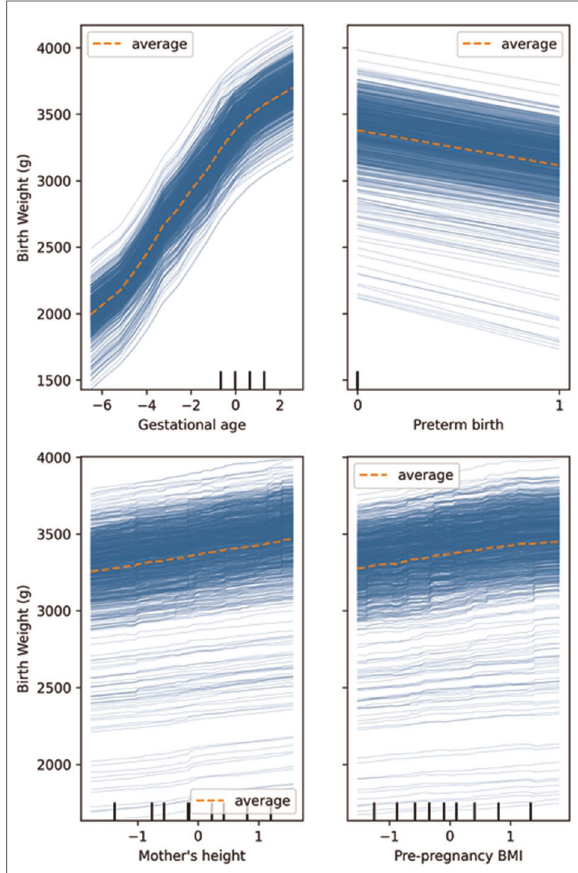
FIGURE 3 Partial dependence plots of gestational age, preterm birth, mother ’ s height, and pre-pregnancy BMI, in the prediction of birth weight in the voting ensemble for regression model (gestational age, mother ’ s height, and pre-pregnancy BMI were standardized; other models in the Supplementary File